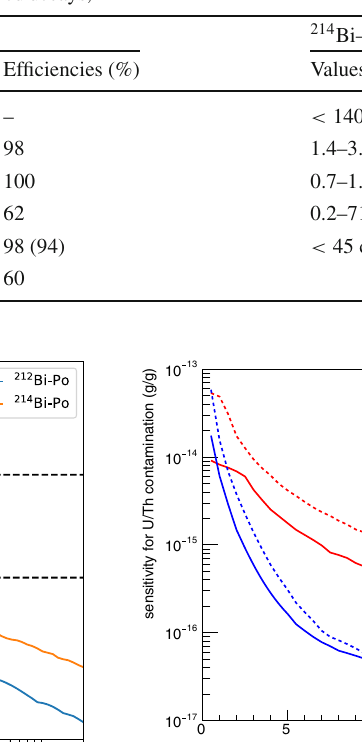
Δ t and Δ r are time and distance cuts. For the latter, the numbers in